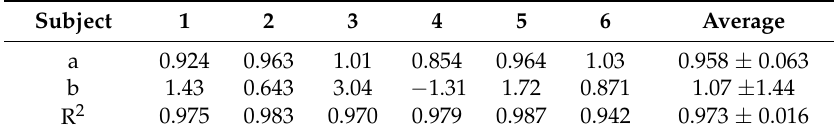
Table 4. Pitch data relation: smart wear data = a × camera data + b, R 2 .